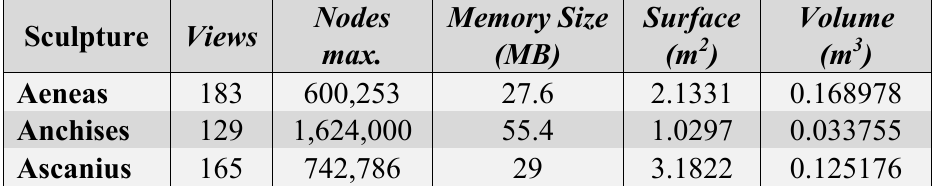
Table 2. Data for the geometrical models of the three big pieces.